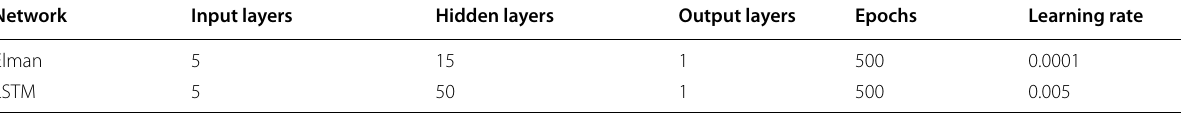
Table 5 The parameters of Elman neural network